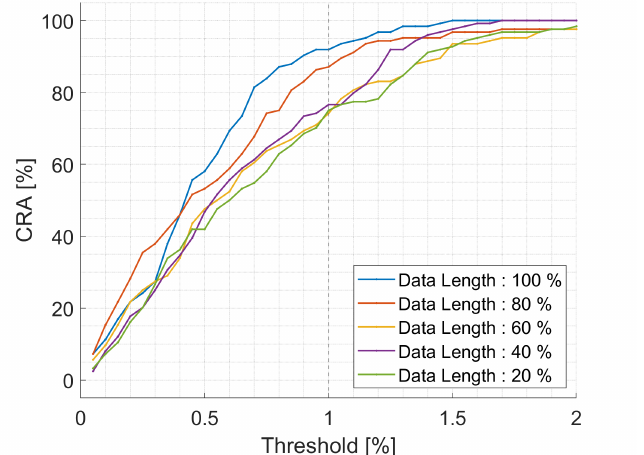
Figure 7. Sensitivity analysis of the neural network’s accuracy depending on the threshold value as described in Equation